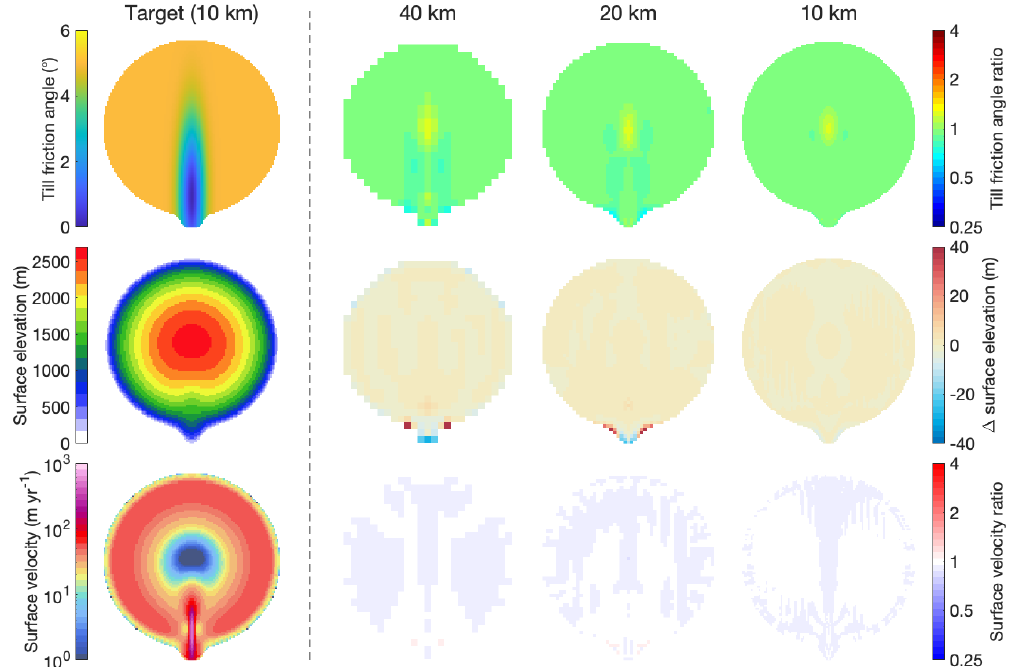
Figure 4. Unperturbed inverted bed roughness, surface elevation, and surface velocity in experiment I at different resolutions, compared to the target. Top row: till friction angle; middle row: surface elevation; bottom row: surface velocity. For the target run (first column), absolute values are shown (colour scales on the left); for the three unperturbed inversions (second–fourth columns), errors with respect to the target are shown (colour scales on the right). For the till friction angle and the surface velocity, the ratios between the inverted and the target values are shown, using a logarithmic colour scale.